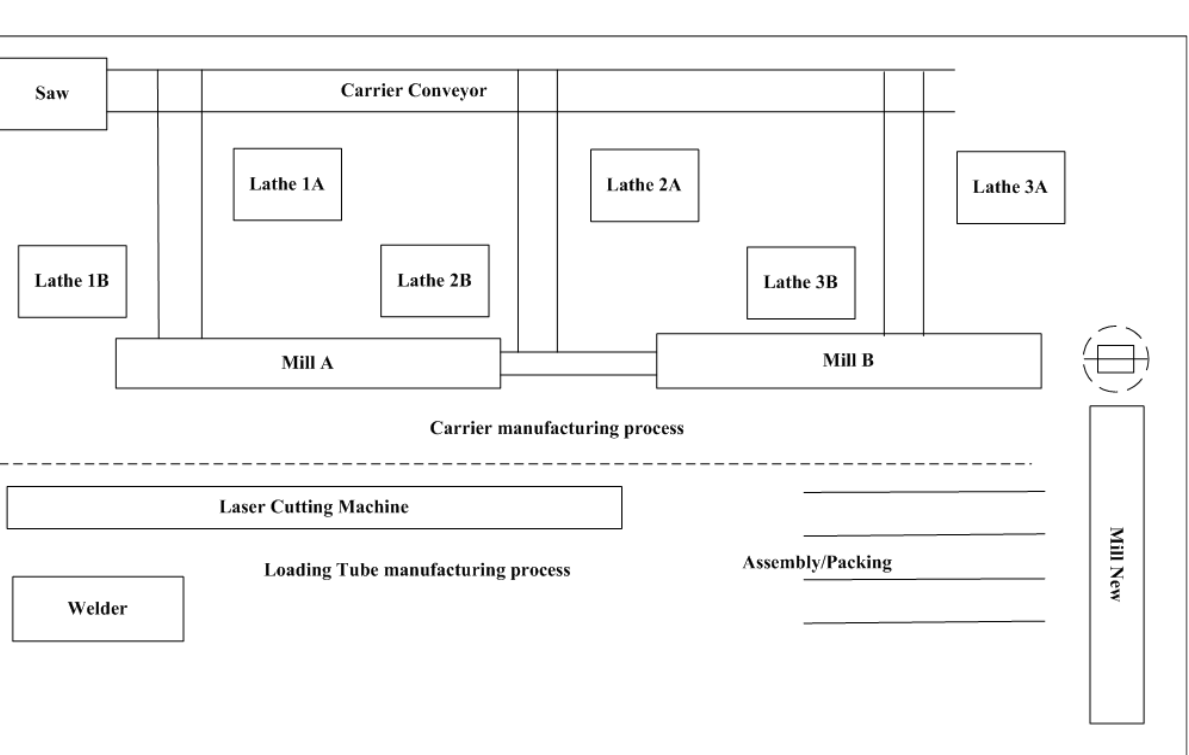
Figure 6. Layout modification of assembly/packing